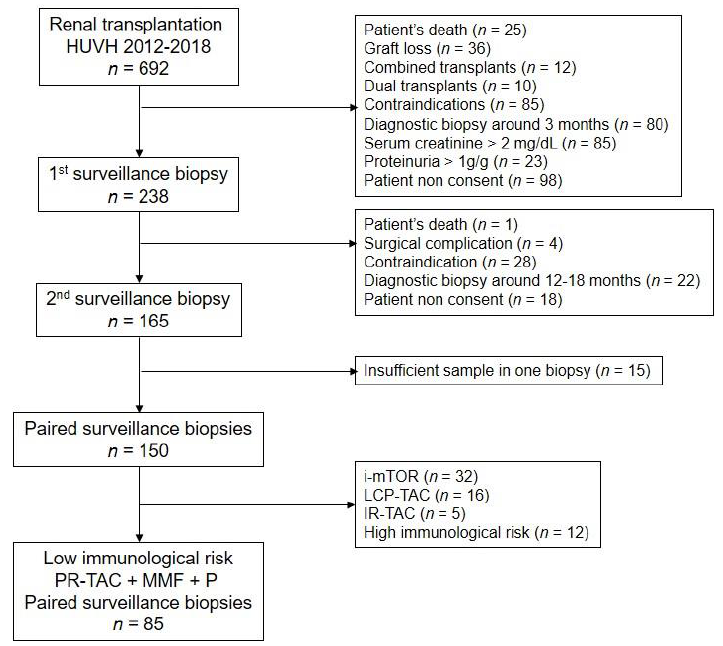
Figure 2. Flow chart of included patients. PR-TAC, prolonged-release tacrolimus; MMF, mycophenolate mofetil; P, prednisone; LCP-TAC, extended-release tacrolimus; IR-TAC, immediate-release tacrolimus; i-mTOR, inhibitors of mammalian target of rapamycin. Contraindications for the first surveillance biopsy include treatment with oral anticoagulants ( n = 33), large abdominal obesity ( n = 26), technical difficulties due to perirenal hematoma or lymphocele ( n = 9), idiomatic barrier ( n = 13), and horseshoe kidneys ( n = 4). Indications for the use of mTOR inhibitors in this cohort was as follows: inclusion in a clinical trial containing i-mTOR de novo or early conversion ( n = 16), polyoma BK viremia during follow up ( n = 6), CMV viremia after prophylaxis in high-risk recipients ( n = 8) and skin cancer ( n = 2). High immunological risk patients were defined as those with HLA donor-specific antibodies at the time of transplant ( n = 7) or receiving a desensitization treatment before transplant ( n = 5). Table 1. Donor and recipient characteristics as well as transplant related-variables from the studied cohort.